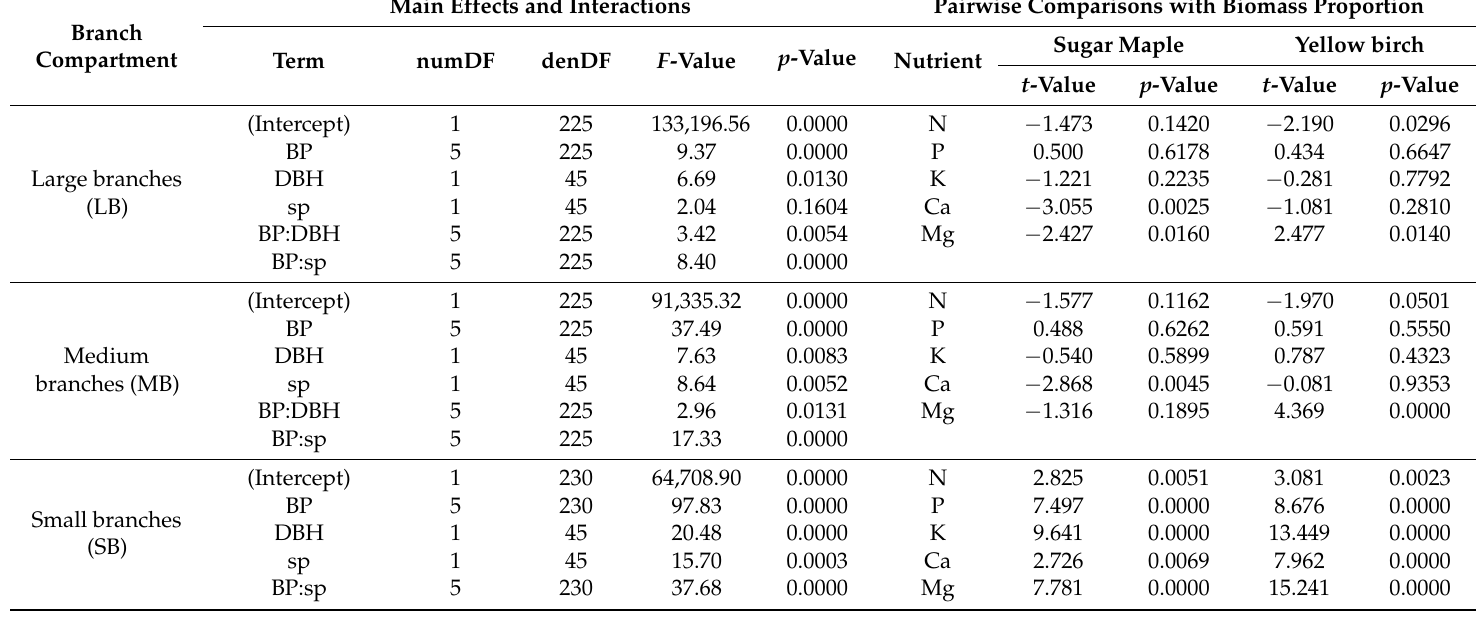
Table 2. Output from the tree selection models for the cumulative nutrient and biomass proportions in each branch compartment. The significance of each term (main effects and interactions) in the selected model is presented on the left-hand side of the table. Note that the term branch parameter (BP) included biomass and thus had six levels. Pairwise comparisons of each nutrient with biomass (the reference level) are provided on the right-hand side of the table. These last comparisons were repeated for sugar maple and yellow birch, given that the branch parameter x tree species interaction (BP:sp) was significant for each model. sp = tree